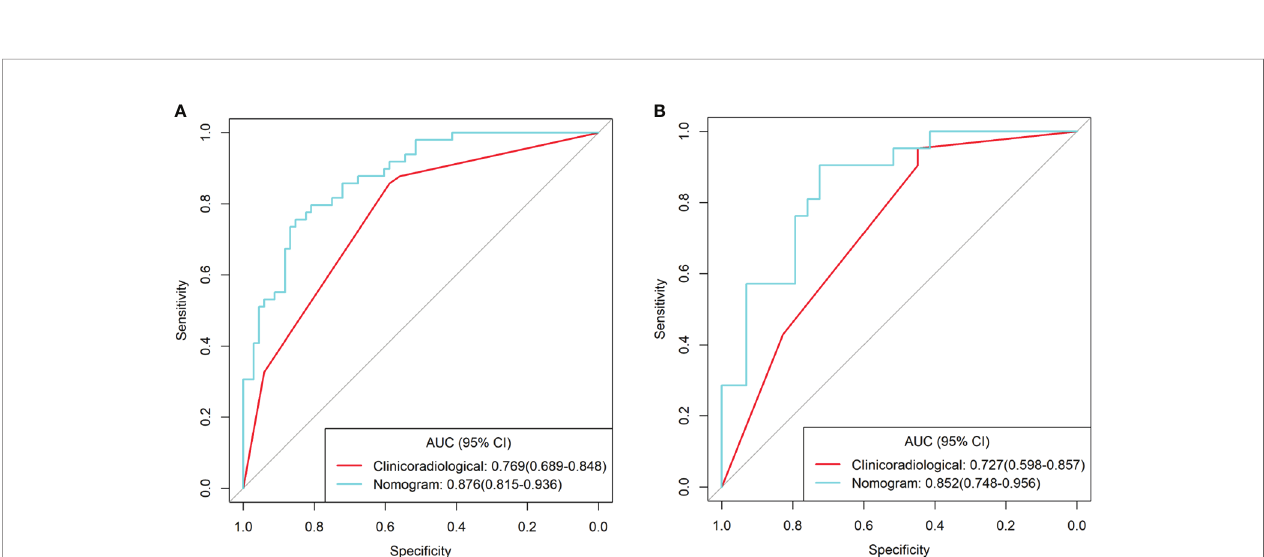
FIGURE 6 | ROC curves of the clinical – DESCT nomogram, clinicoradiological model, and spectrum-combined model for preoperative prediction of LNM in patients with colorectal cancer in the training cohort (A) and validation cohort (B) .